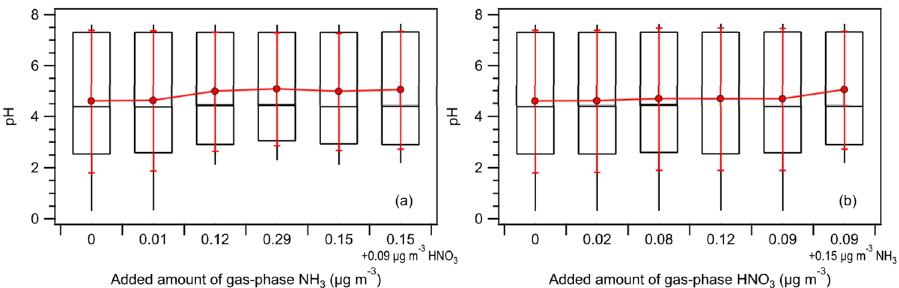
Figure 1 . Box plots depicting the median pH values calculated by ISORROPIA-II for the different concentrations of gas-phase ( a ) NH 3 , and ( b ) HNO 3 added into the system. Standard box-and- whisker plots are shown, with the 90th and 10th percentile data indicated by black error bars. The top and bottom of the box are the interquartile ranges (75th and 25th percentile) centered around the median value (50th percentile). The red symbols denote the means, and the red error bars are 1 standard deviation.